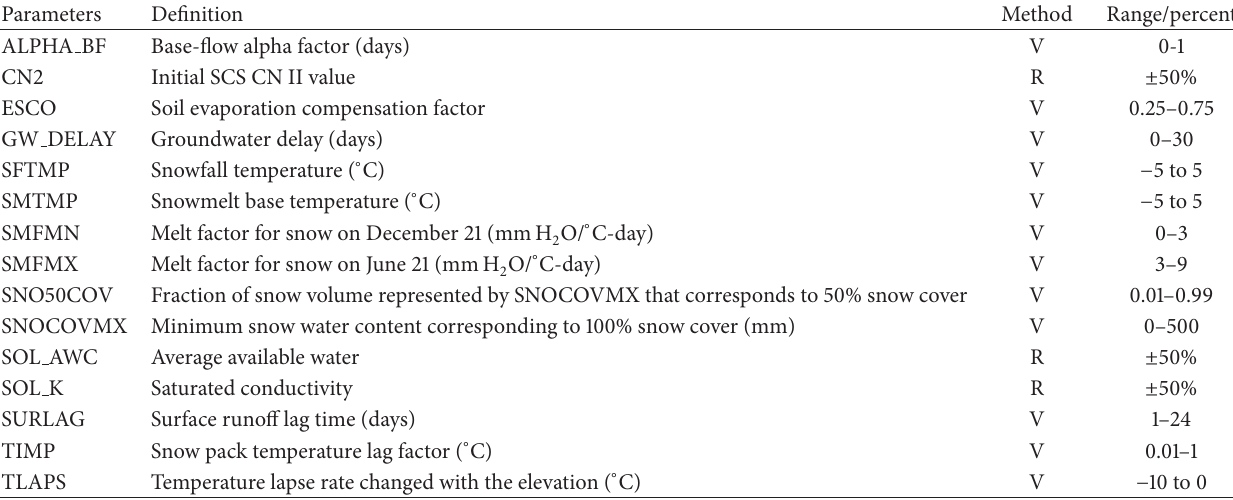
Table 7: Calibration parameters in Elev 𝑇 𝑎 and New 𝑇 𝑎